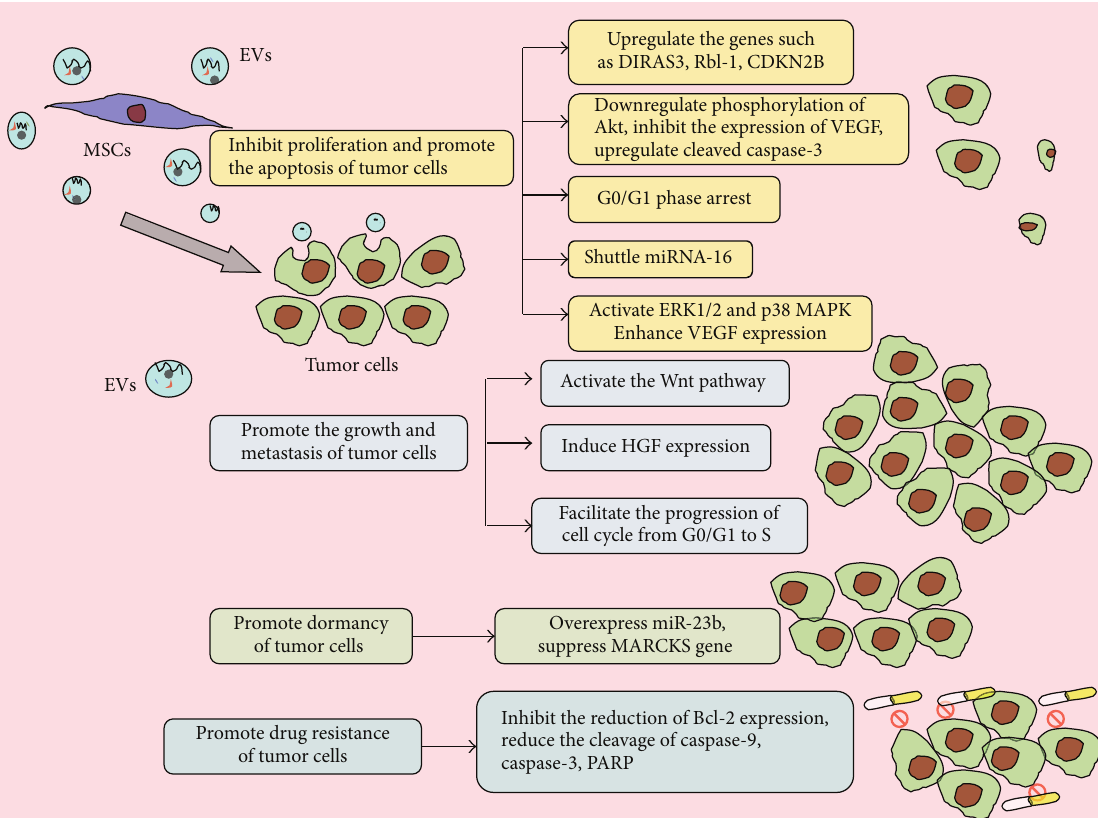
Figure 2: The different effects of MSC-EVs on the growth, metastasis, and drug response of different tumor